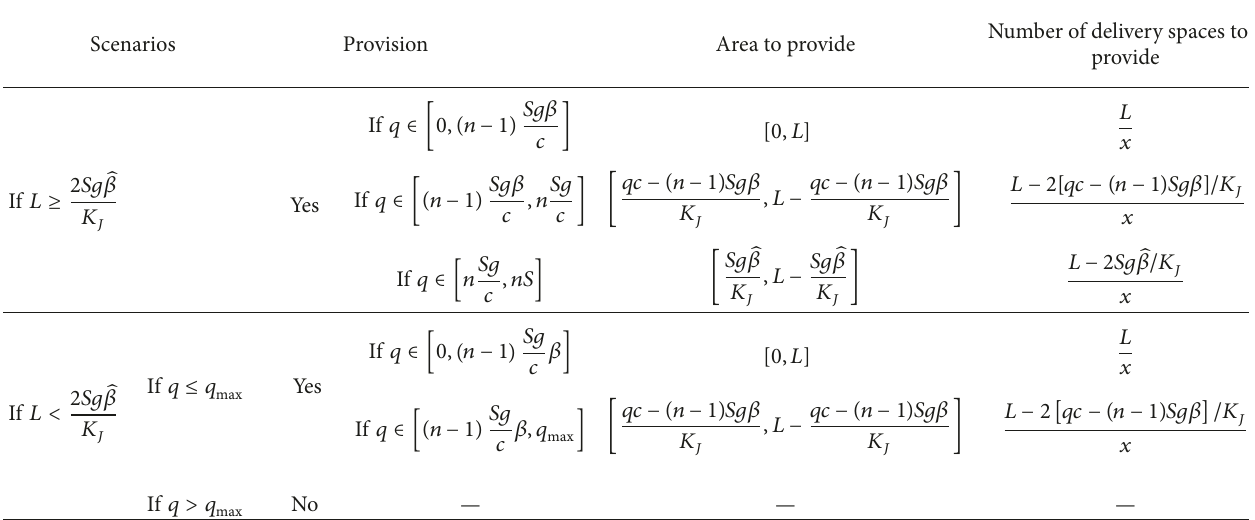
Table 1: Provision suggestions on the dynamic delivery areas under various conditions.